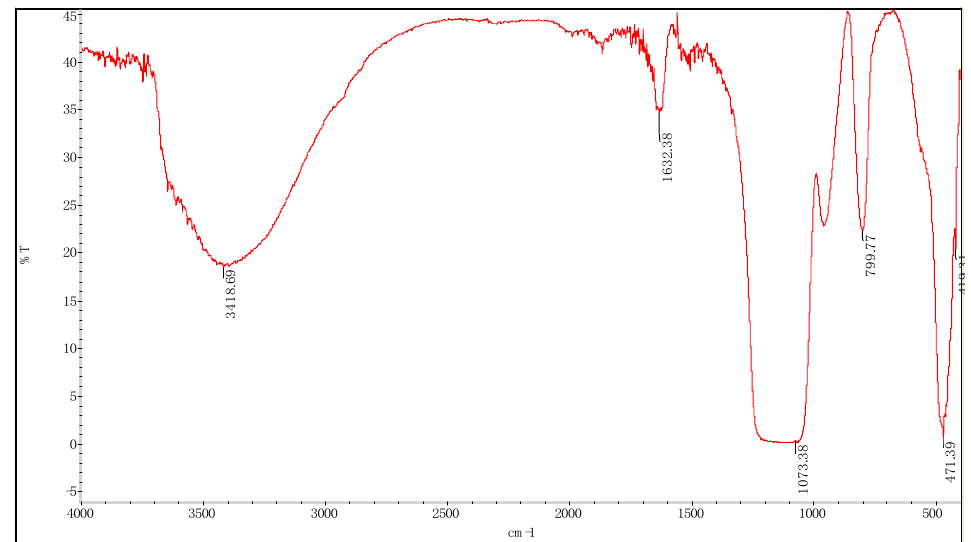
Figure 10. Fourier transform infrared spectroscopy of silica (bare) particles.